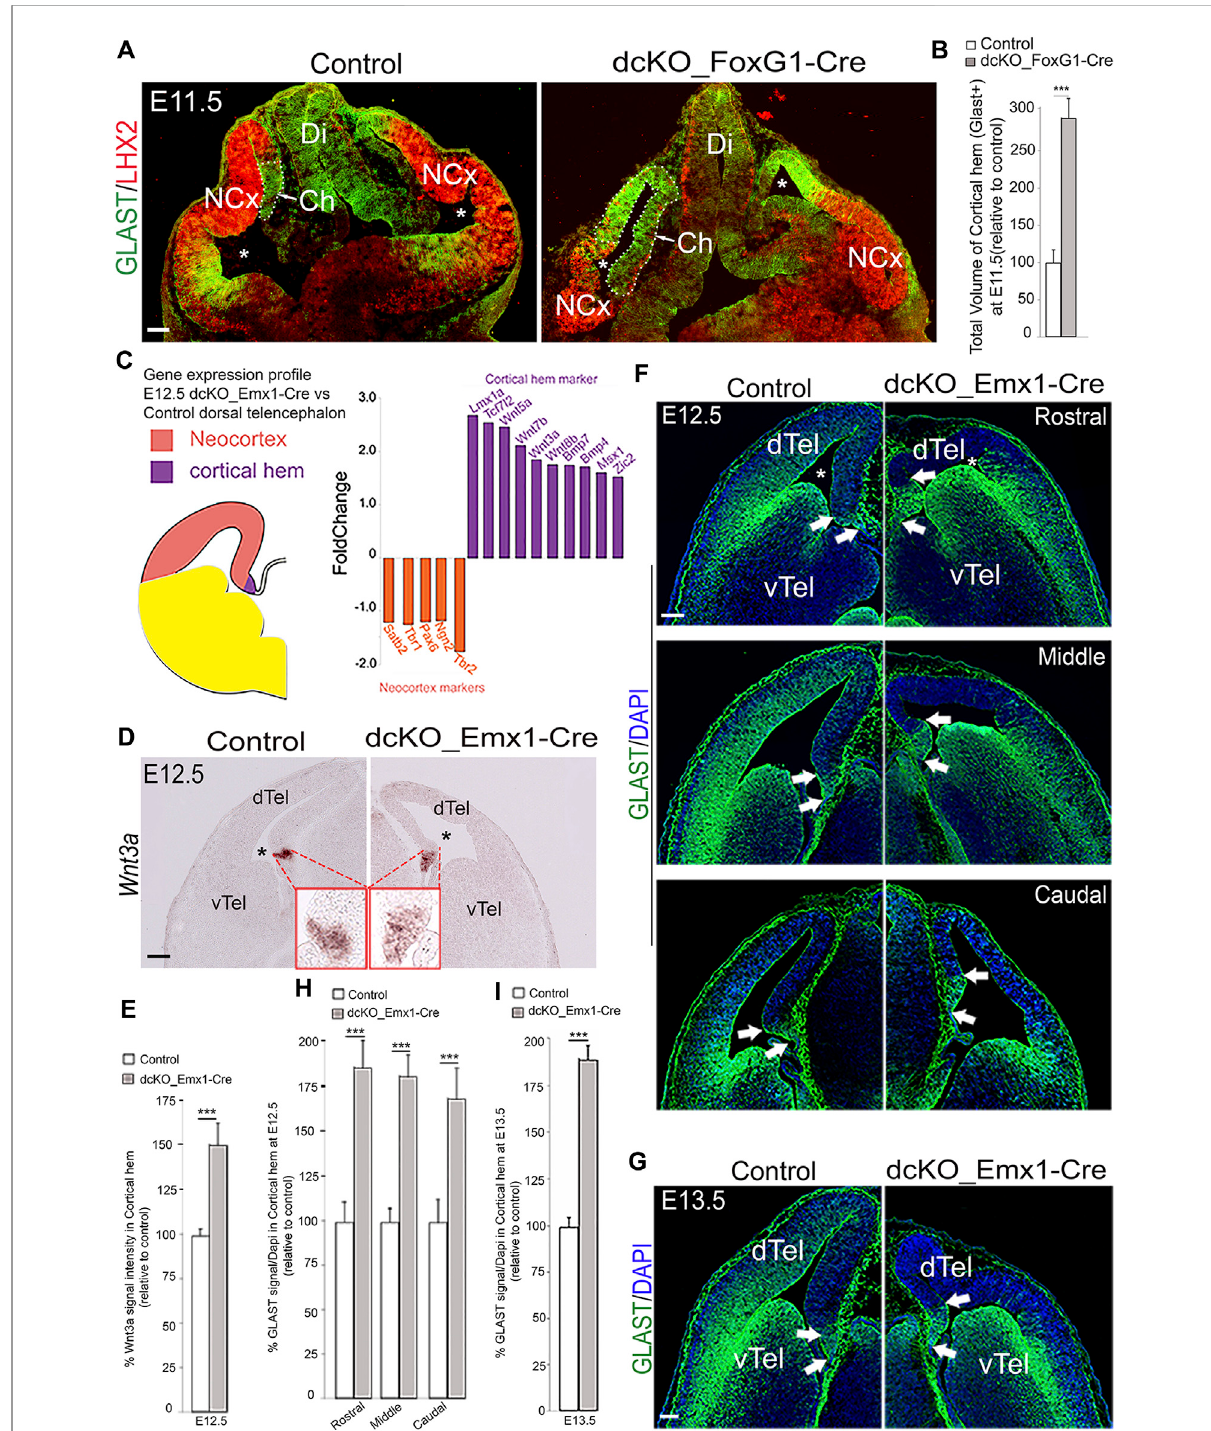
FIGURE 2 BAFcomplexablationcauses abnormalcorticalhemenlargement. (A) ImagesoftheE11.5mousewhole headsectionsshowingthedeveloping forebrain stained with LHX2 and GLAST antibodies to reveal the presumptive neocortex and the cortical hem (delineated with stippled lines) of the control and dcKO_Foxg1-Cre telencephalon, respectively. (B) Bar chart indicating the statistical difference between the estimated total volume of control and dcKO_Foxg1-Cre corticalhems. (C) Schematic showingdemarcation oftheneocortexfromthecortical heminhemisectionofthe mousetelencephalon.ResultsofRNAsequencingoftheE12.5controland dcKO_Emx1-Cre corticaltissuesindicatingfoldchangeofdownregulated neocortical marker genes (orange bars) and upregulated hem maker genes (purple bars) in the dcKO_Emx1-Cre are graphically represented. (D)